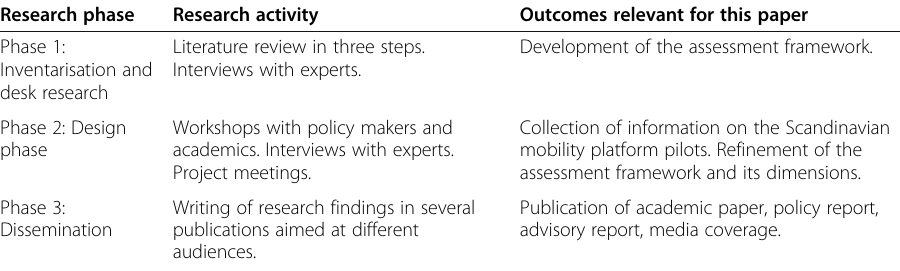
Table 1 Short version of the research approach (see full methodology in Appendix